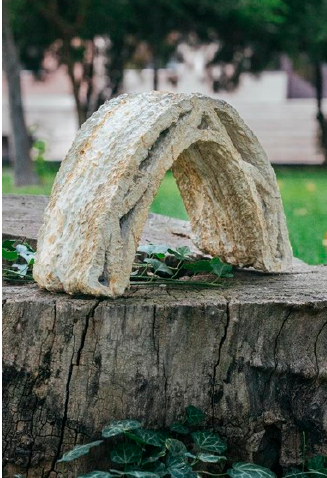
Figure 14. The extruded vault made of MBC material bound by bio-welding (Image credit: Authors).